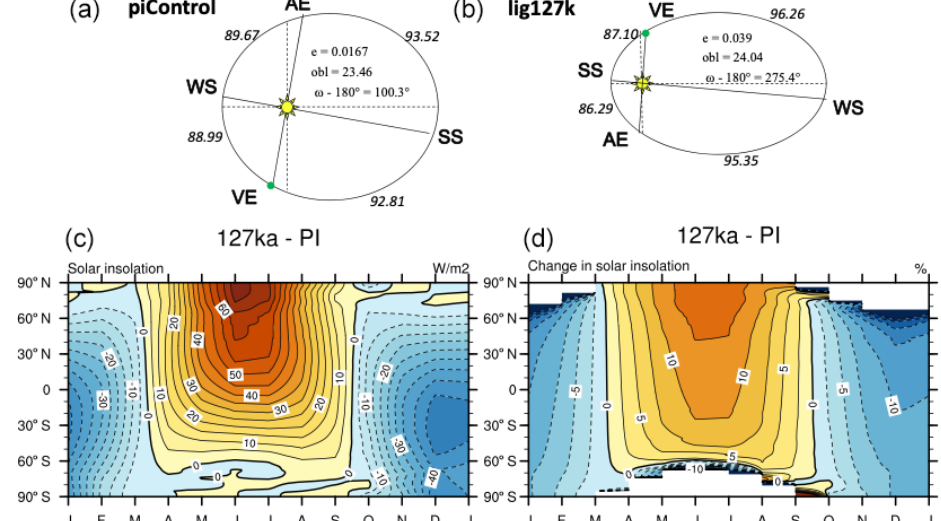
Figure 1. (a, b) Orbital configurations for the piControl and lig127k experiments. The number of days between the vernal equinox and summer solstice, summer solstice and autumnal equinox, etc., are indicated along the periphery of the ellipse. Latitude–month insolation anomalies 127ka–1850 in (c) Wm − 2 and (d) percentage change from PI.